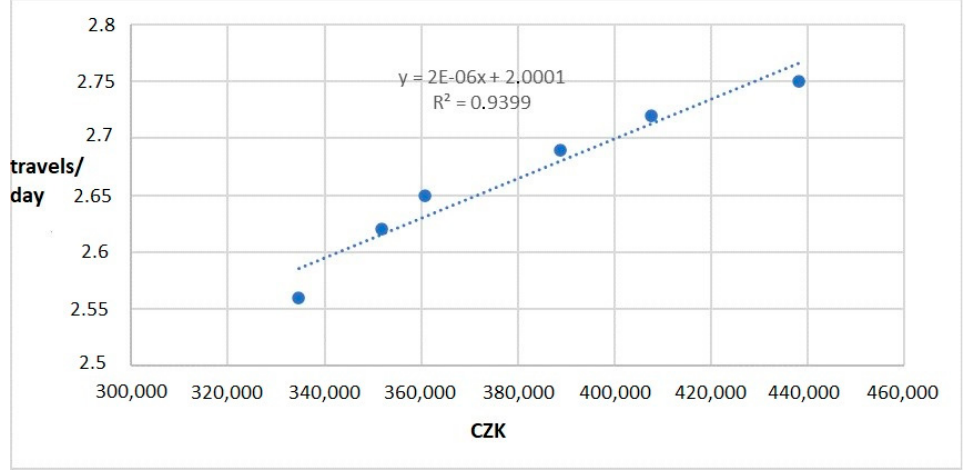
Figure 5. Regression line describing a correlation between residents’ movability and GDP per cap- ita.